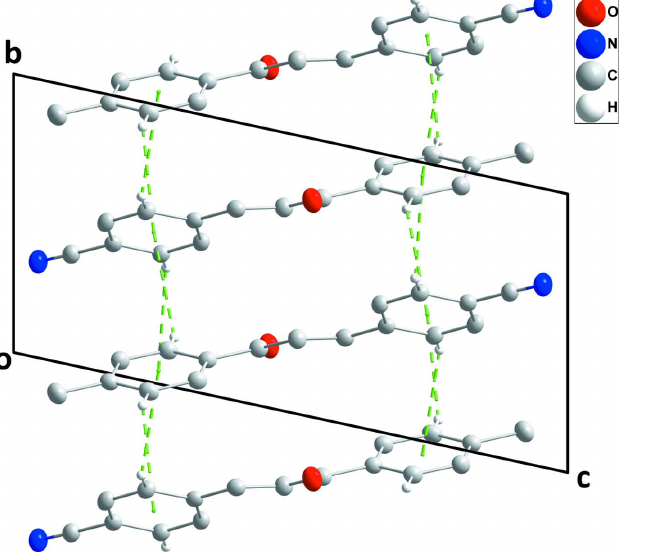
Figure 2 Elevation view of a portion of one layer viewed along the a -axis direction with C—H (cid:3)(cid:3)(cid:3) (cid:2) (ring) interactions depicted by dashed lines.